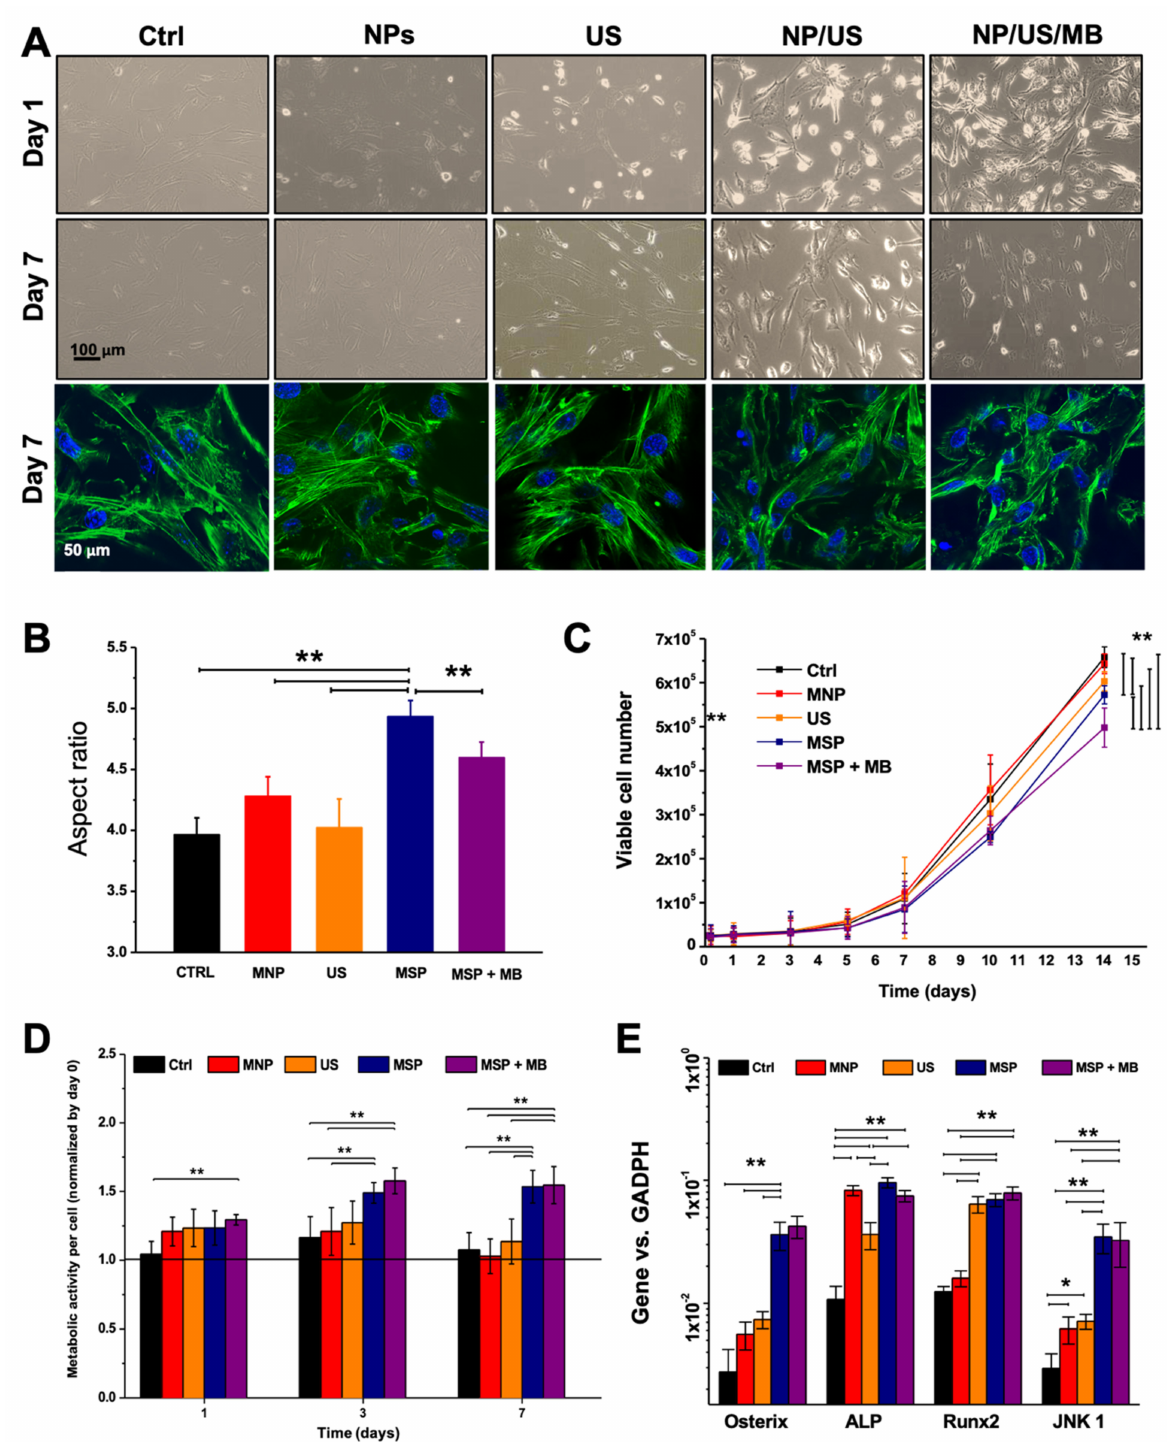
Figure 2. Biological effects. ( A ) Cell morphology was observed in phase contrast microscopy and in fluorescence microscopy (actin displayed in green, nuclei in blue). ( B ) Aspect ratio of cells was calculated one week after the various treatments. ( C ) Proliferation rate of ASCs measured as viable cell numbers over time. ( D ) Metabolic activity per cell in the different conditions, normalized to the DNA content, relative to day 0. ( E ) Gene expression of ASCs one week after sonoporation, focused on the expression of genes involved in osteogenesis and mechanical transduction. Asterisks indicate significant dif- ference (by two-way analysis of variance (ANOVA)): * p < 0:05; ** p < 0:01. MNP = magnetic nanoparticles; US = ultrasounds; MB = microbubbles. MSP =